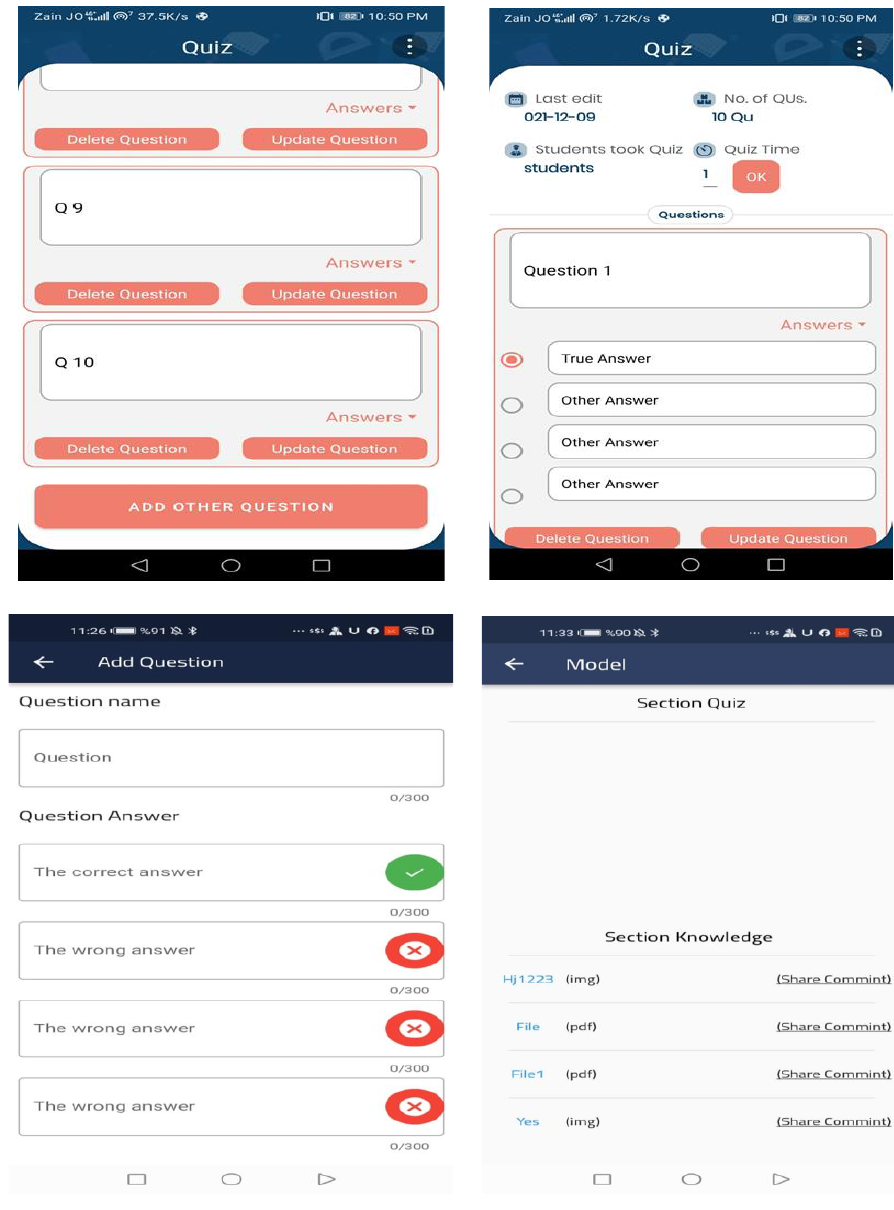
Figure 8. Exam control screen.